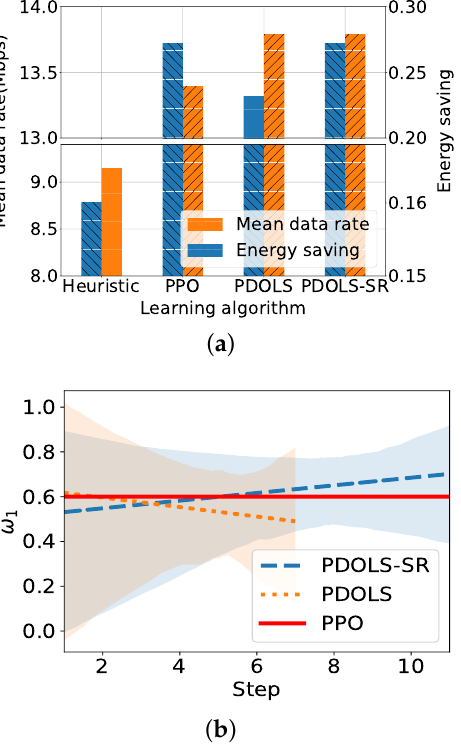
Figure 8. Performance comparison of proposed algorithms. ( a ) Average UE data rate and energy consumption. ( b ) Reward weight vector